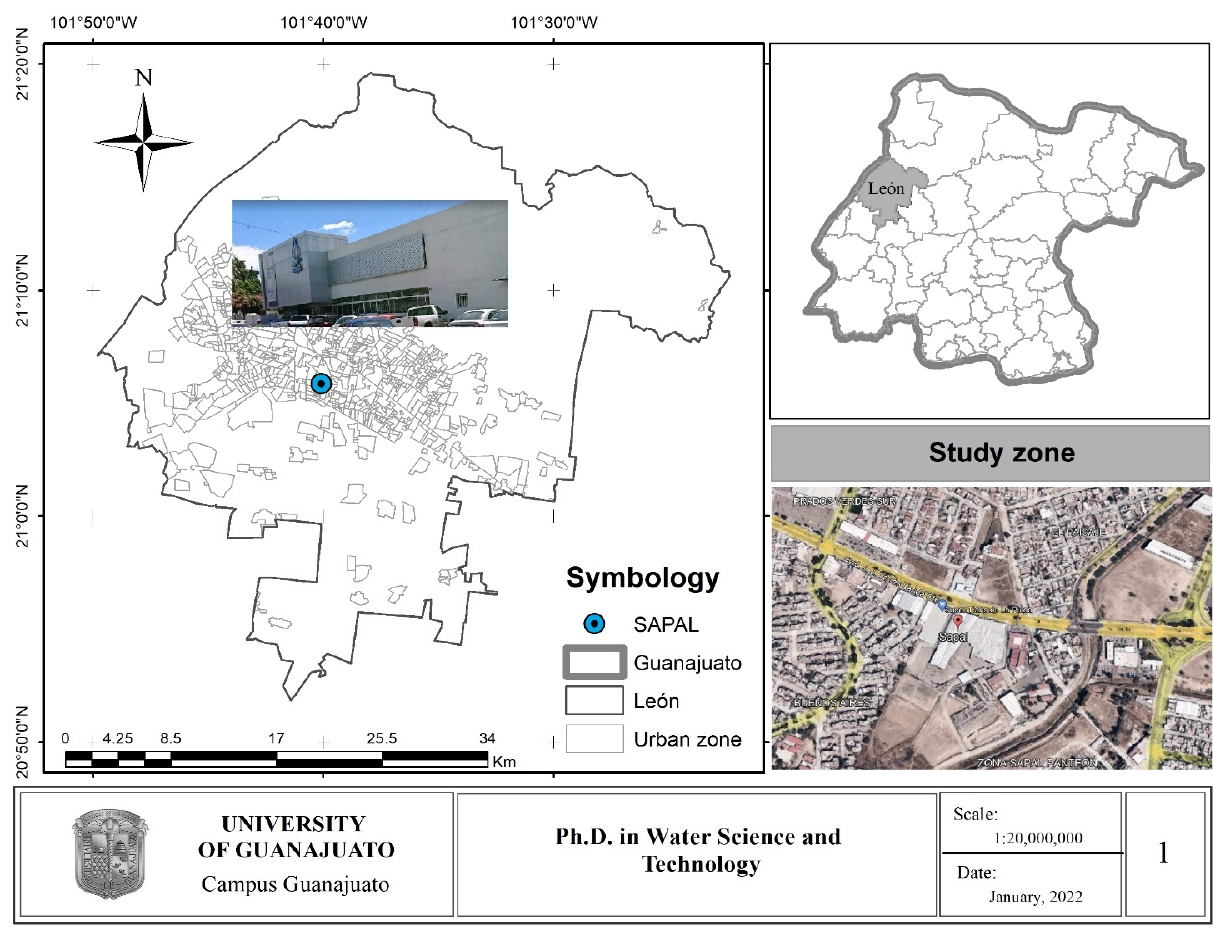
Figure 1. Location of Leon